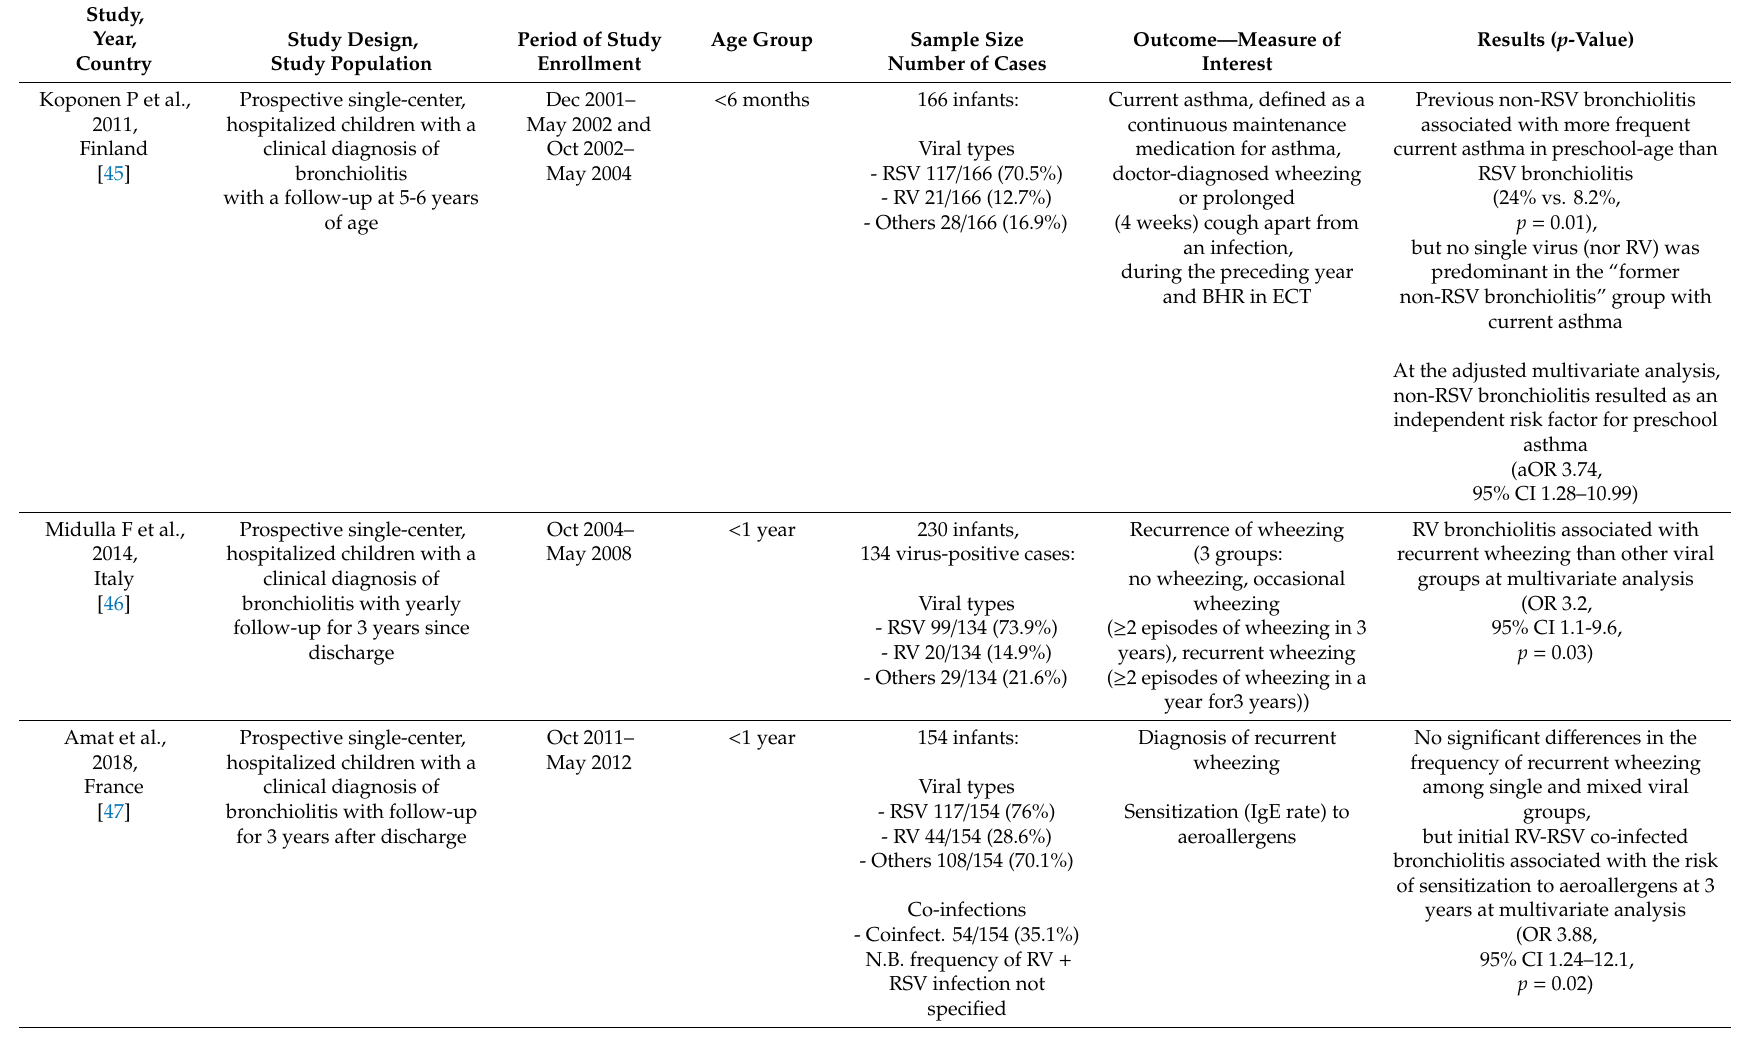
Table 2. Principal studies evaluating the correlation between rhinovirus bronchiolitis and preschool wheezing or